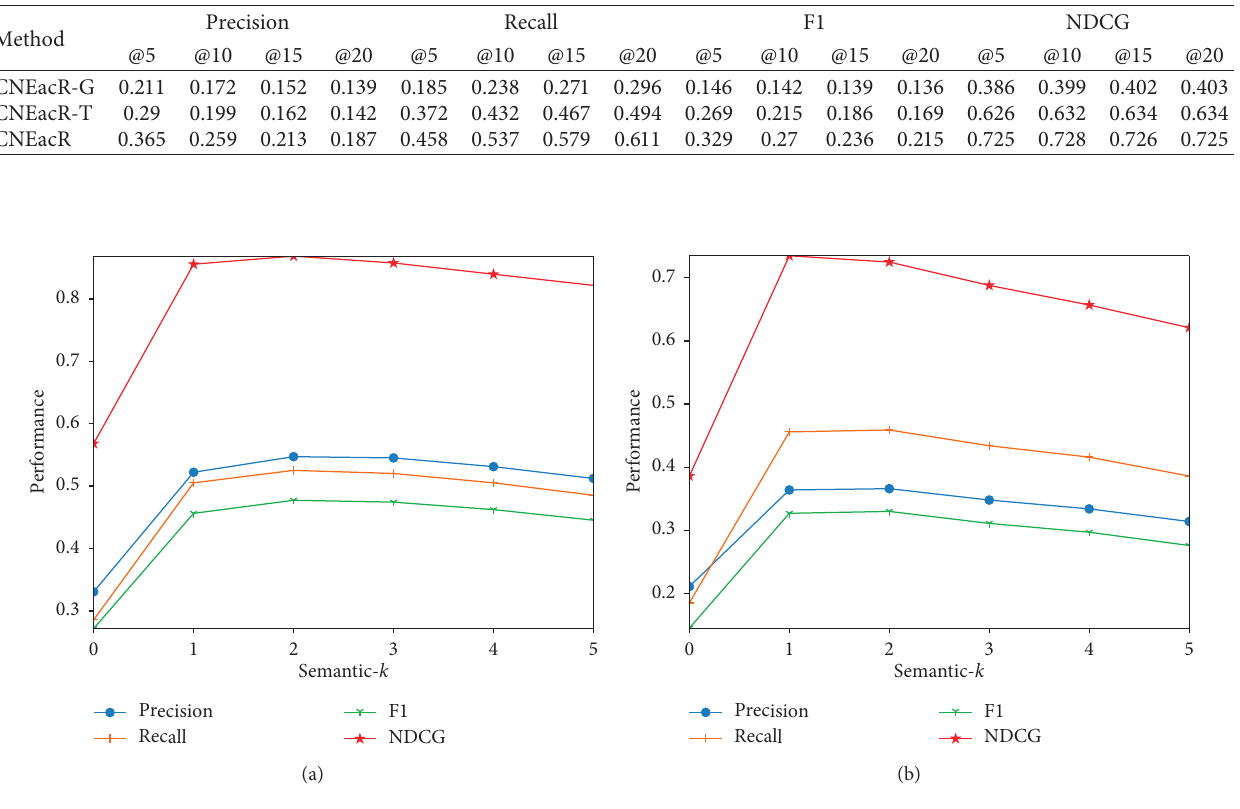
Figure 3: Performance in different SK relationships in two datasets. (a) Performance in different semantic- k relationships in PRB. (b) Performance in different semantic- k relationships in